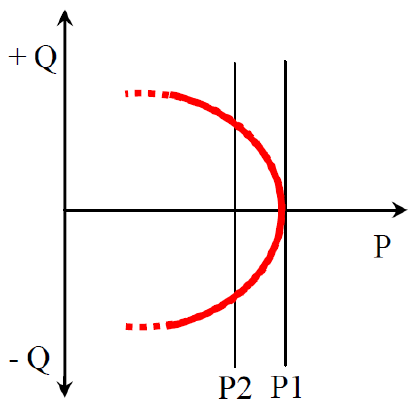
Figure 4. PV inverter reactive power capability based on current limits.